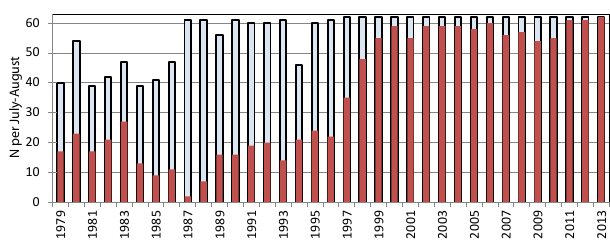
1979 1981 1983 1985 1987 1989 1991 1993 1995 1997 1999 2001 2003 2005 2007 2009 2011 2013 Figure 3. Number of daily satellite data sets used in the analysis of the July–August seasons of 1979–2013. Column height shows the total number of daily data sets with valid ocean data, the red filled part shows the number of daily data sets with detected accumula-